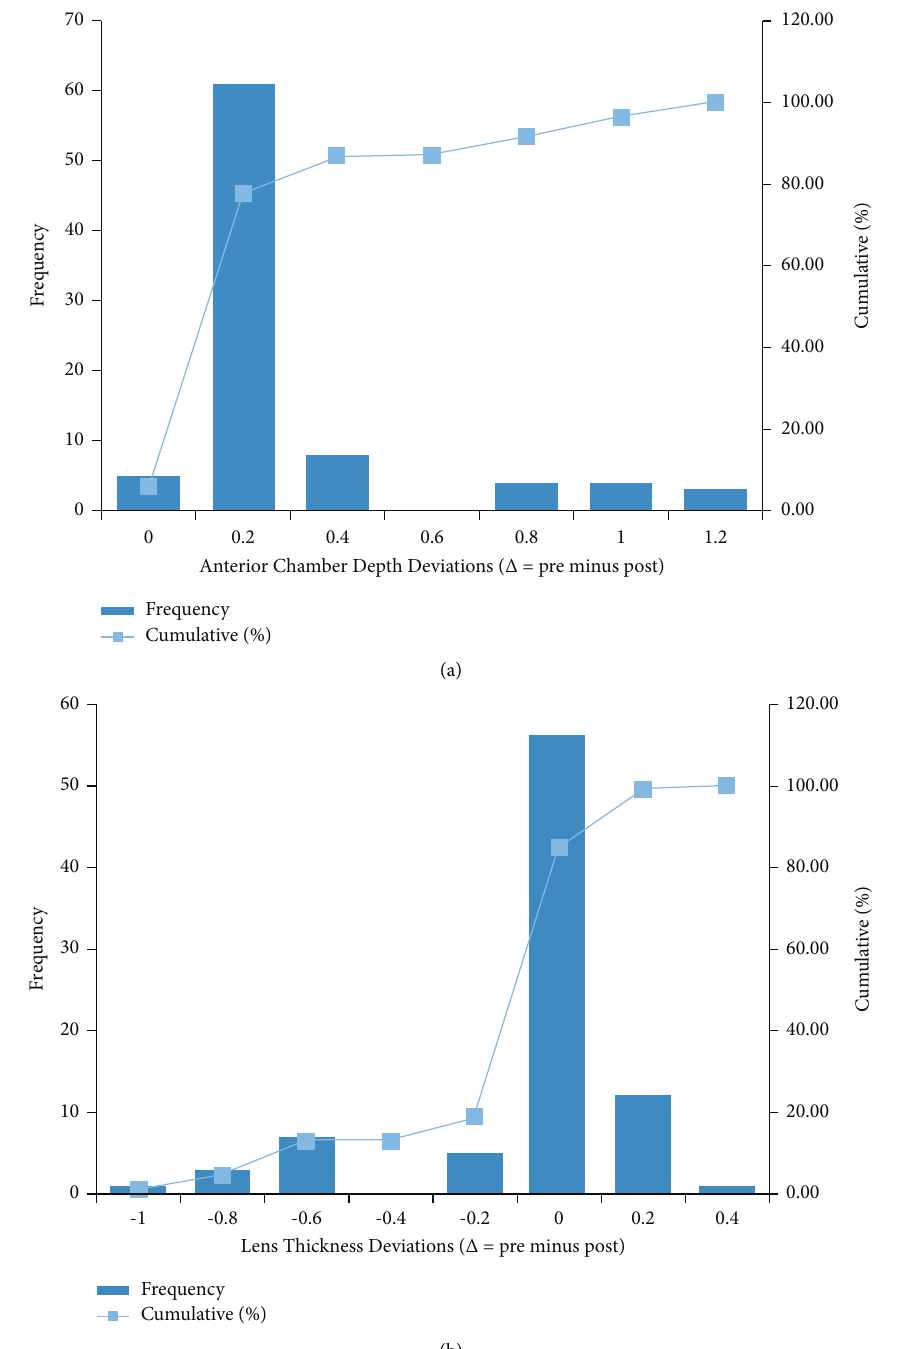
Figure 1: (a) The distribution of preoperative and postoperative anterior chamber depth deviations ( ∆ � pre minus post). (b) The dis- tribution of preoperative and postoperative lens thickness deviations ( ∆ � pre minus